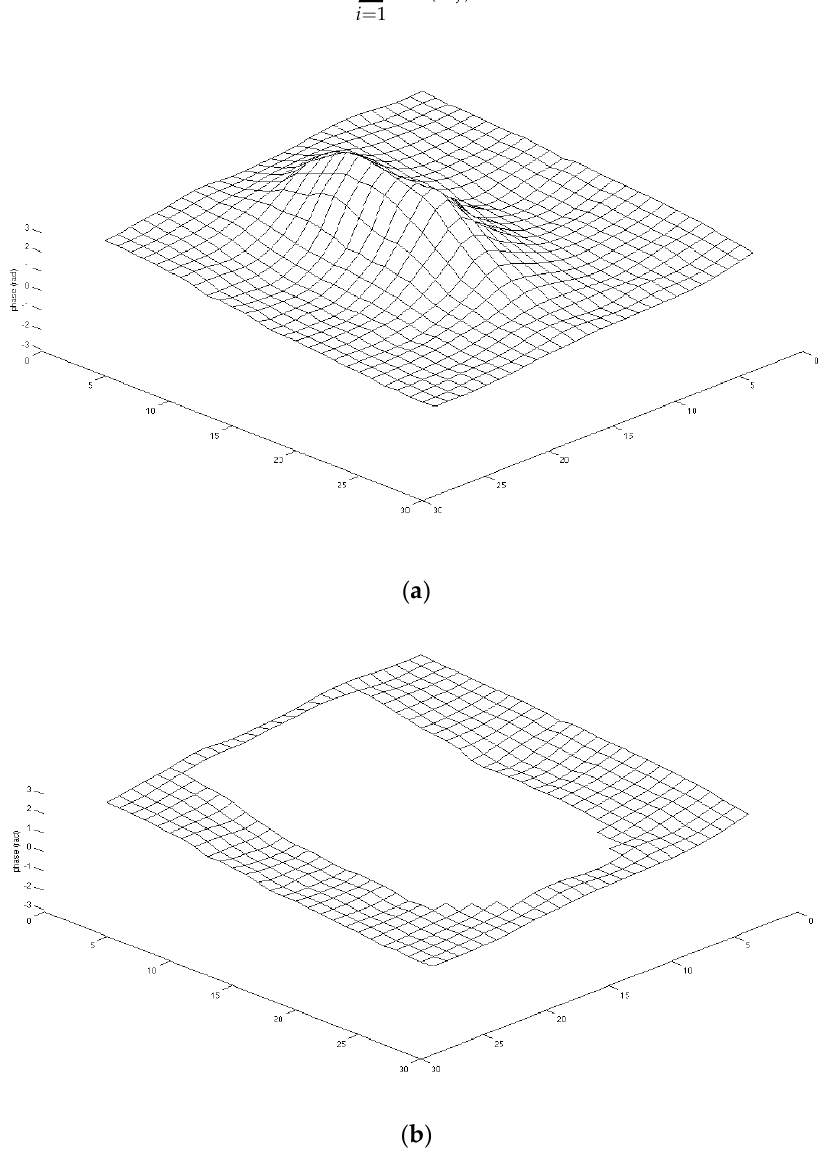
Figure 6. ( a ) 3D plot of a phase map with sonicated area; ( b ) 3D plot of the outer region of the phase map in ( a ) after removing the sonicated area.